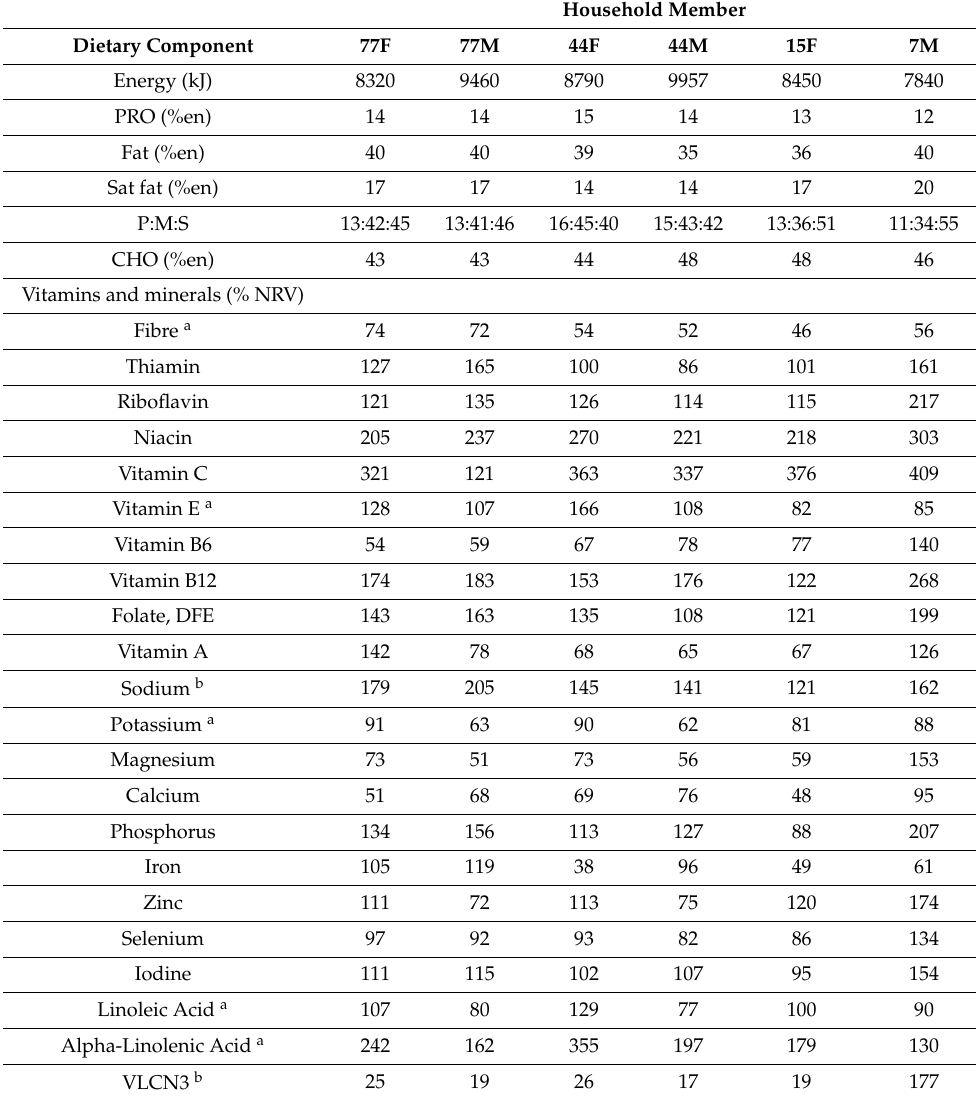
Table 9. Summary of average daily nutrient intake by household member for the Western Diet food